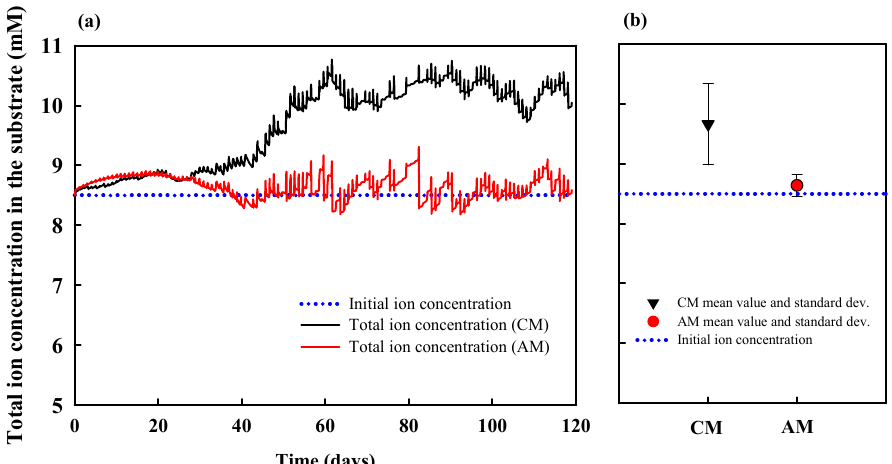
Figure 3. Changes in total ion concentration in the substrate according to the nutrient-replenishment method ( a ) and mean and standard deviation of total ion concentration in the substrate according to the nutrient-replenishment method ( b ). CM is the conventional nutrient-replenishment method and AM is alternative nutrient-replenishment method (Equation (13) applied).